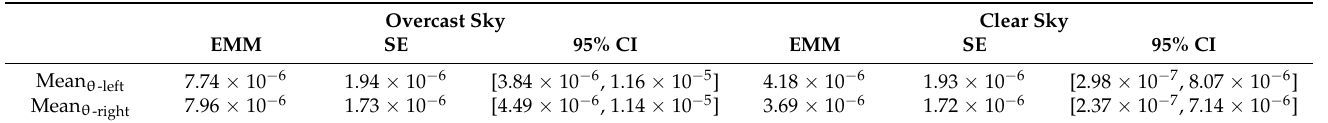
Table 9. Estimated marginal means (EMM), standard errors (SE) and 95% confidence intervals (CI) per EEG attribute and sky type (without